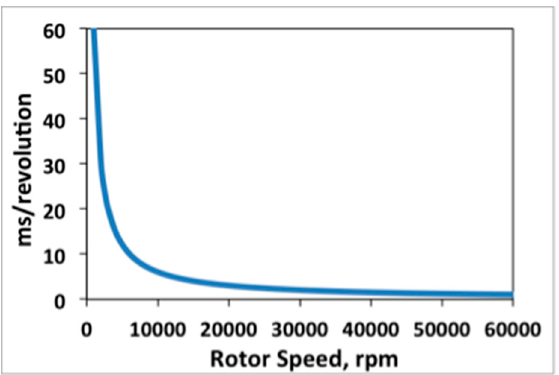
Figure A5. Inverse relationship of rotor speed versus period of rotation.